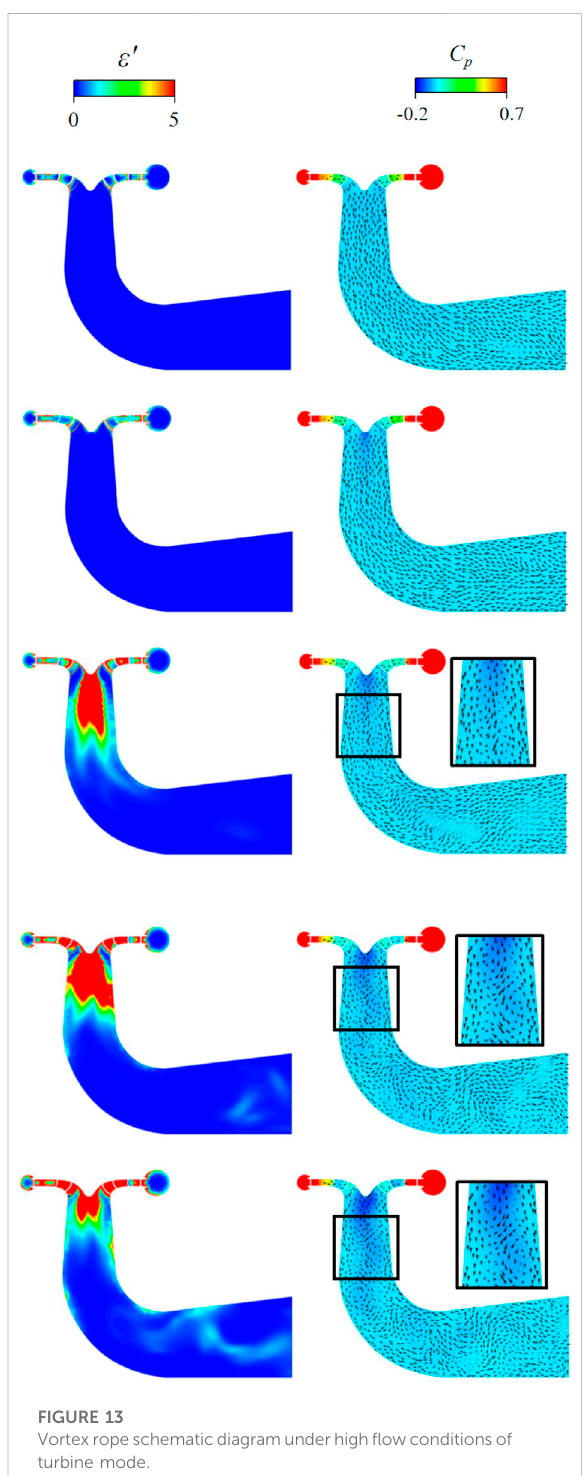
FIGURE 13 Vortexropeschematicdiagramunderhigh fl owconditionsof turbine